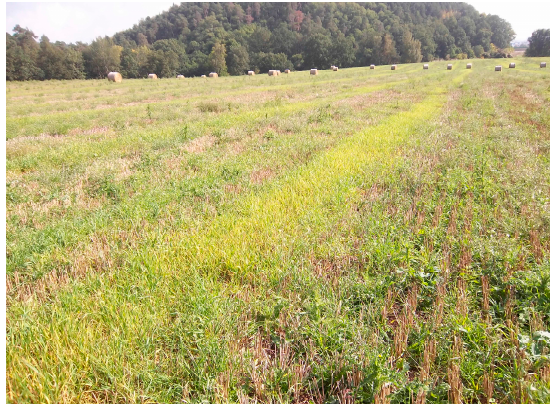
Figure 2. Postharvest situation of the wheat crop in late September. Weeds in the 9-m cutting span of the harvester thresher accompany the dense chlorotic regrowth of spilt wheat grains within the former 1.6-m wide straw discharge.